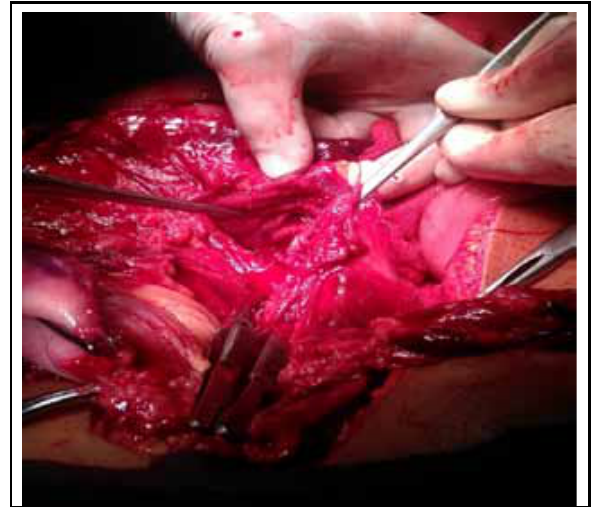
Figure 3. Operative picture.